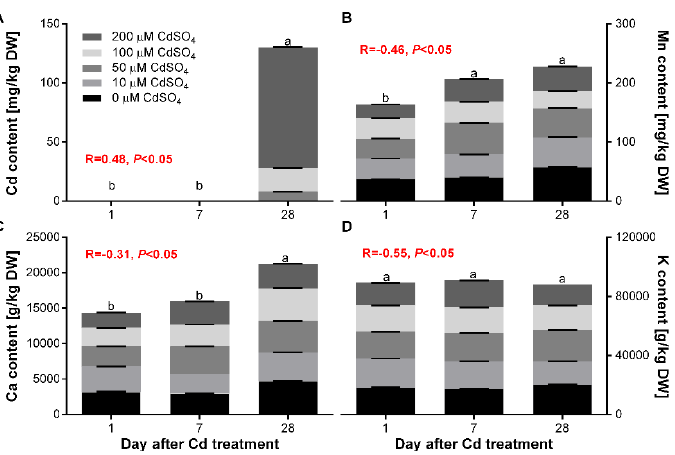
Figure 2. Accumulation of Cd ( A ), Mn ( B ), Ca ( C ) and K ( D ) in the plants during the experiment and Cd-treatment. Each value is the mean of three replicates ± SD. Different letters represent significant differences ( p < 0.05). The statistically significant results of the correlation analysis are presented as Pearson’s correlation coefficients (R).